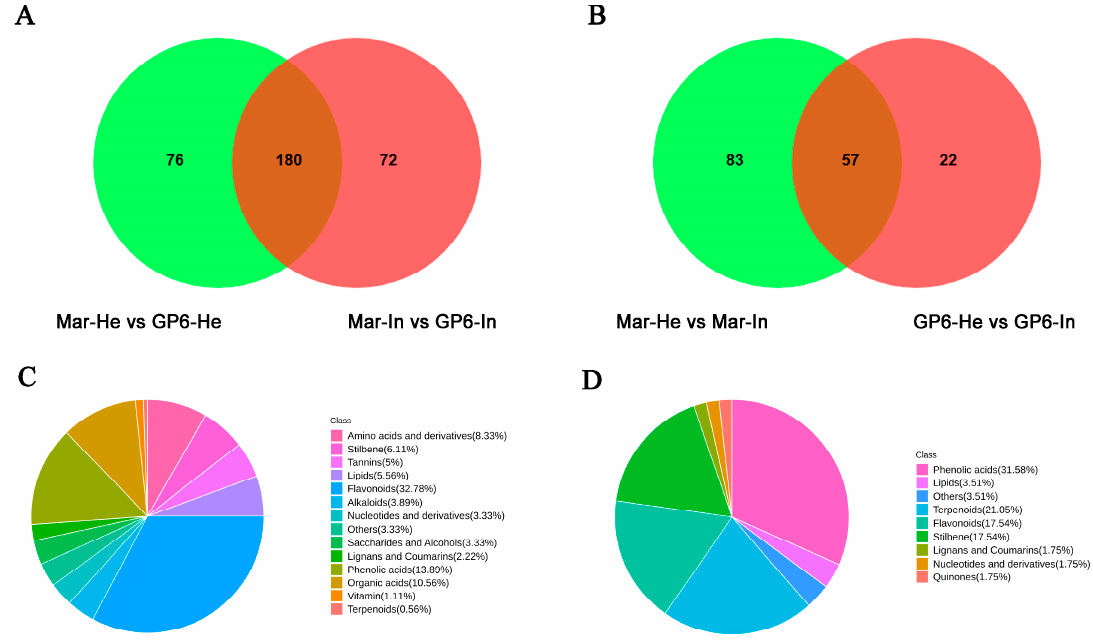
Figure 5. ( A ) Venn diagram between Mar-He vs. GP6-He and Mar-In vs. Gp6-In; ( B ) Venn diagram between GP6-He vs. GP6-In and Mar-He vs. Mar-In; ( C ) The classification of the 180 key metabolites; ( D ) The classification of the 57 key metabolites.